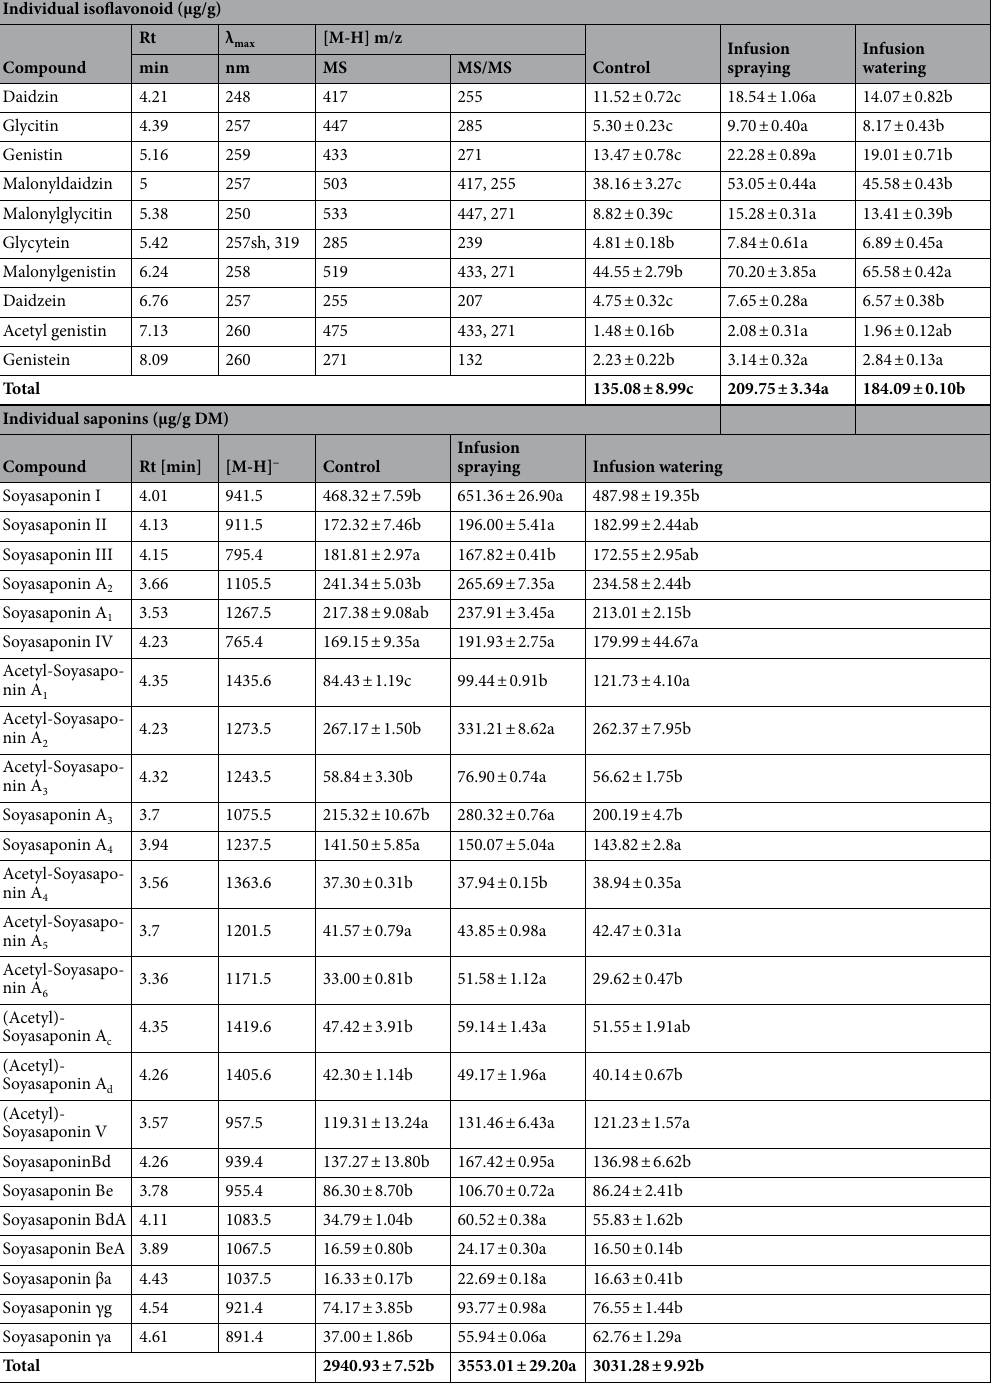
Table 7. Individual isoflavonoid and saponins compounds identified by UPLC-PDA-MS/MS in soybean seeds (means of 2018–2020 ± SD). Means in the rows, concerning the selected traits, followed by different letters are significantly different at p <